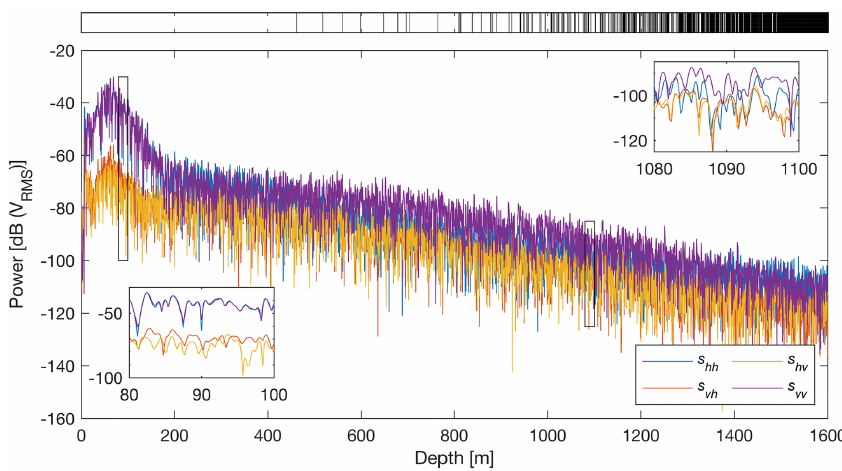
Figure 3. Mean (polarization-averaged) power return for each antenna orientation combination acquired at Site I. Insets show magnification of power returns at two different 20m intervals. The top bar shows range bins (black) that fall below the noise floor and were excluded from further